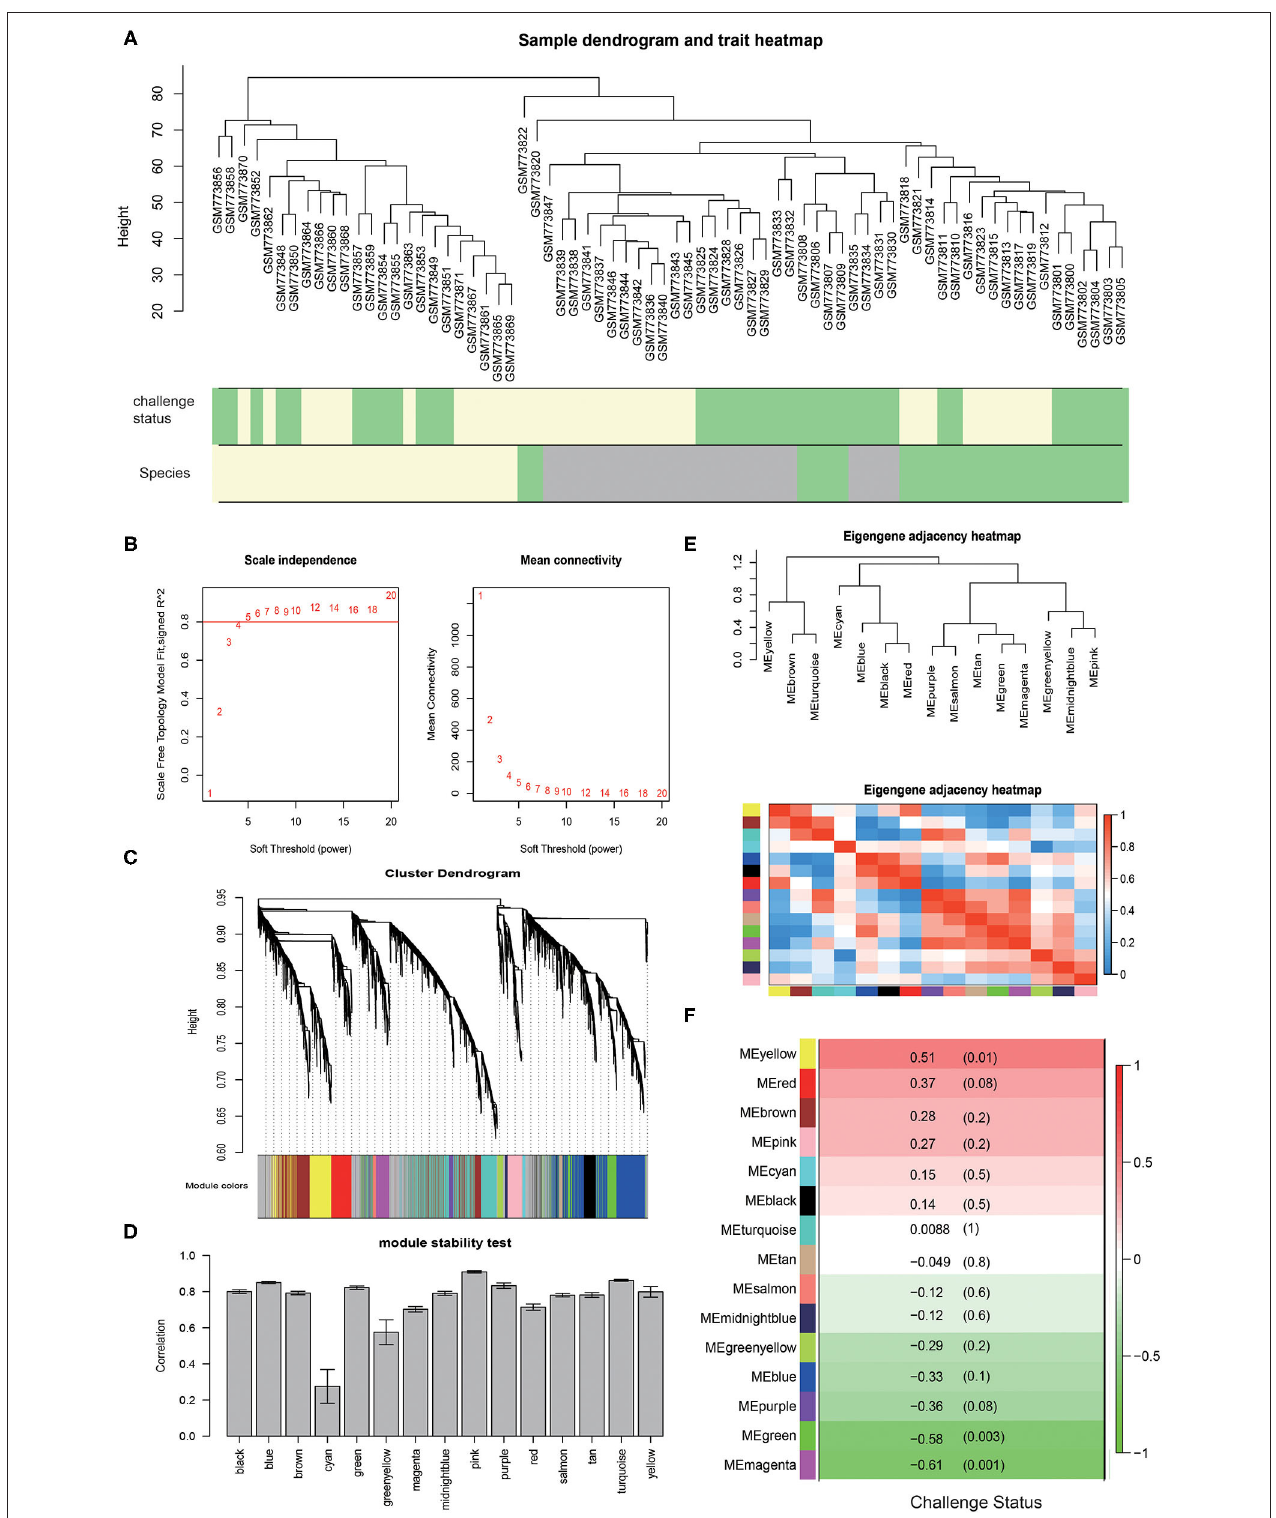
FIGURE 1 | The WGCNA results for chickens infected with E. tenella. (A) The samples clustering for chickens infected by E. acervulina (lightgreen), E. maxima (gray), and E. tenella (lightyellow) with the primary infection (lightgreen) and secondary infection (lightyellow). (B) The scale independence curve and the mean connectivity curve. (C) The dendrogram for the modules constructed by WGCNA. (D) Correlation of intramodule connectivity for each module after sampling 1,000 times (mean ± sd). (E) Module clustering and heatmap. (F) The module-trait analysis results.